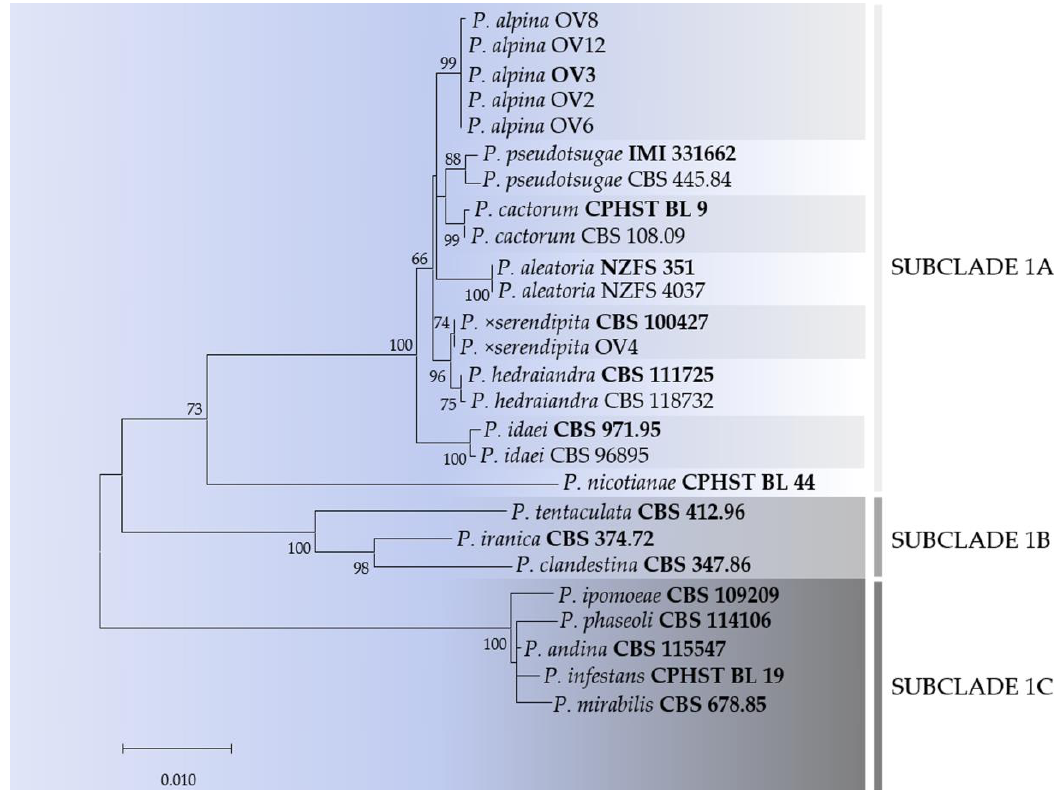
Figure 3. Maximum likelihood tree obtained from concatenated internal transcribed spacer (ITS), ß-tubulin (Btub) and cytochrome c oxidase subunit I ( cox 1) sequences of Phytophthora species belonging to ITS clade 1. Data are based on the General Time Reversible model. A discrete Gamma distribution was used to model evolutionary rate differences among sites. The tree is drawn to scale, with branch lengths measured in the number of substitutions per site. Bootstrap support values in percentage (1000 replicates) are given at the nodes. Ex-type cultures are in bold.